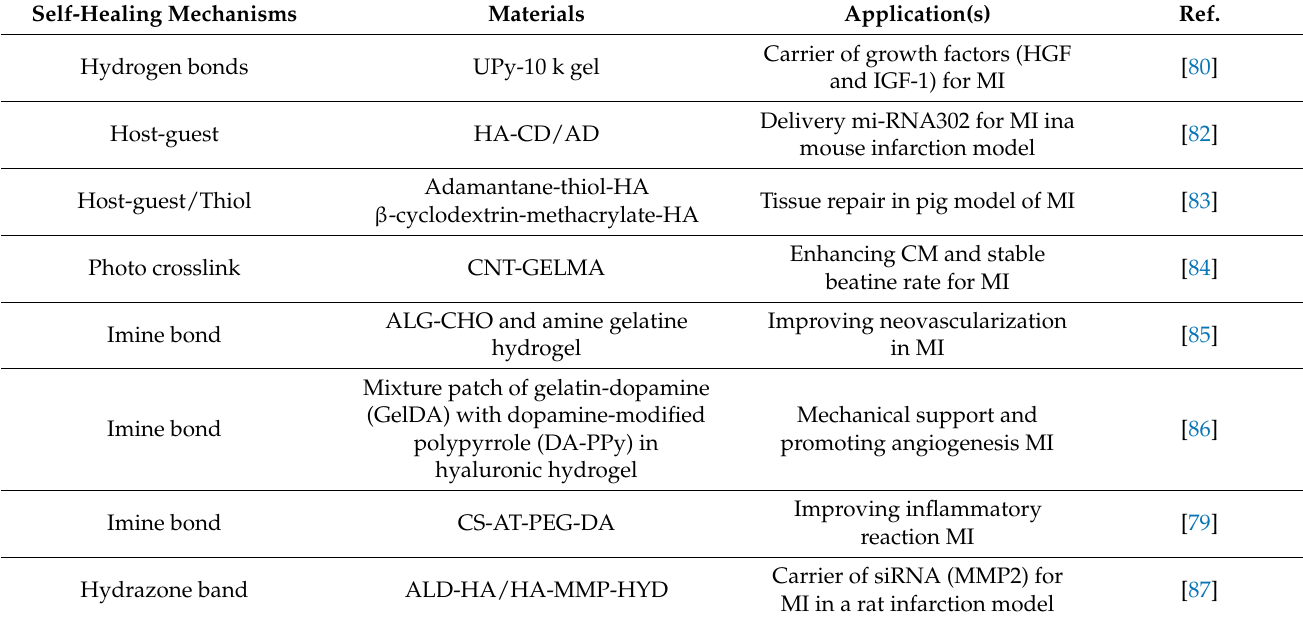
Table 4. Examples of self-healing hydrogels for heart